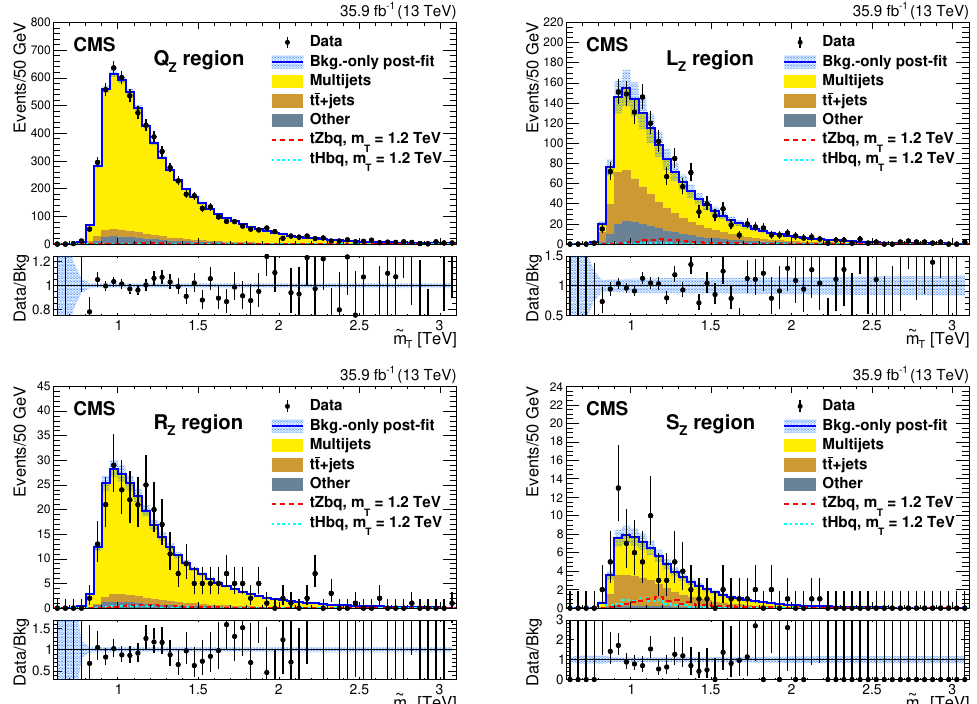
Figure 7 . The background-only post-(cid:12)t distributions in data for the Q that are used as signal and control regions primarily for the T ! tZ channel. The upper plots show regions Q (left) and L (right), while the lower plots show regions R Z Z dashed red histogram is an example T ! tZ signal for the tZbq process with a 1.2 TeVT quark mass and a fractional width of 30% with a cross section from the singlet model of 131 fb. The shorter dashed cyan histogram is for T ! tH signal for the tHbq process with the model assumptions used in (cid:12)gure 6. The lower panels show the ratio of observed data to (cid:12)tted background per bin. The error bars on the data represent 68% CL Poisson intervals. The light blue band in each ratio panel shows the fractional uncertainties in the (cid:12)tted